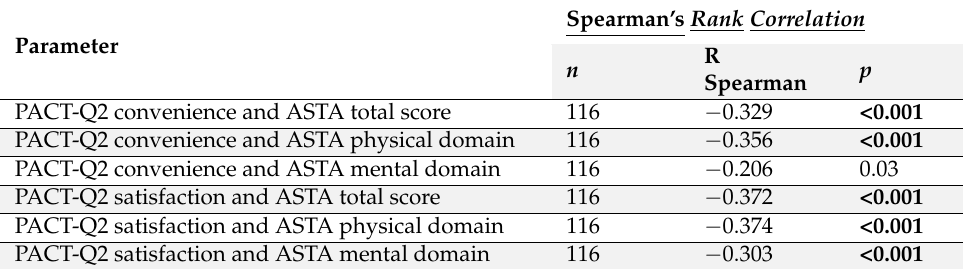
Table 5. Analysis of correlation between convenience and satisfaction (PACT-Q2) and quality of life (ASTA) of the study group ( n =